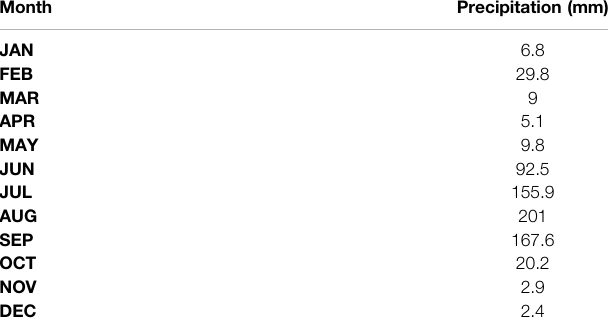
TABLE 3 | Monthly precipitation in the state of Morelia, Mexico.